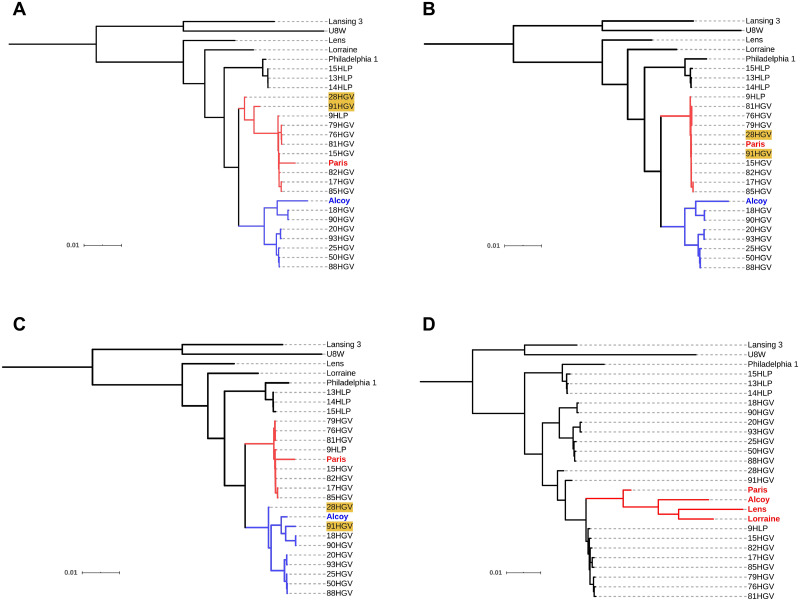
Impact of reference choice on phylogenetic trees of L. pneumophila.ML trees included the selected reference sequences of L. pneumophila and the consensus sequences obtained from mappings against strains (A) Philadelphia 1, (B) Paris, (C) Alcoy and (D) Lansing 3. Clusters of isolates related with references Paris (red) and Alcoy (blue) are coloured in the first three phylogenies. Isolates 28HGV and 91HGV (highlighted in yellow) were placed in different clades in the trees when using references Paris and Alcoy. Clade of references resulting from using Lansing 3 as reference genome is coloured in red.